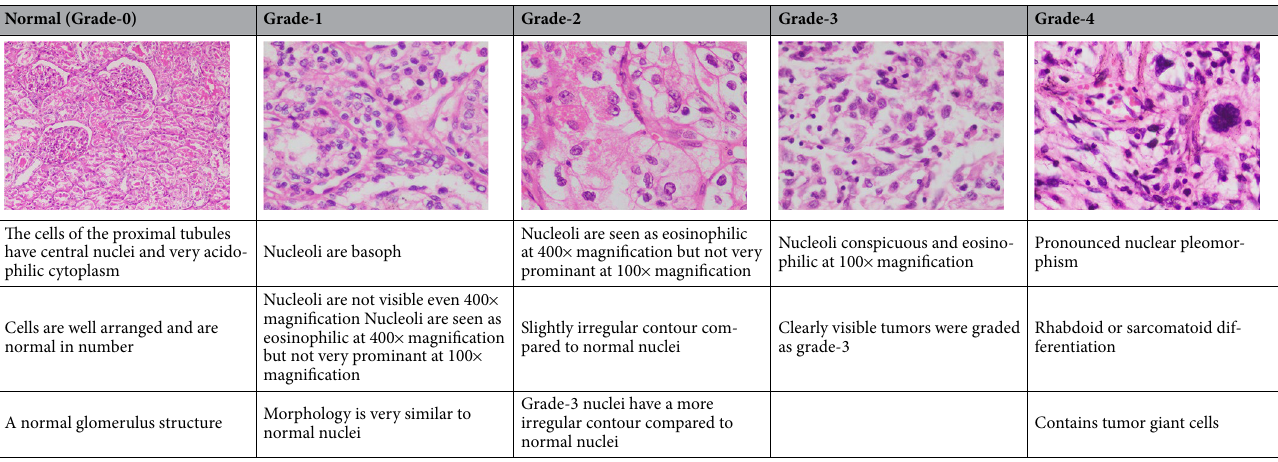
Table 1. Visualization of different grades of renal tumor (normal to Grade-4 from left to